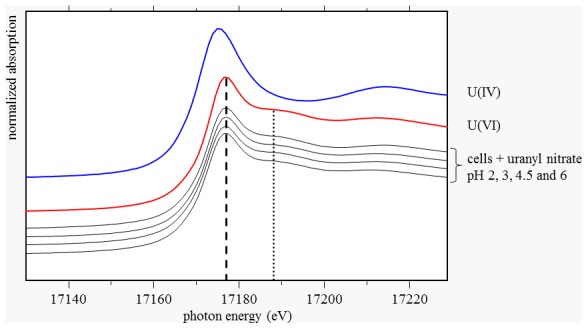
Uranium L
III-edge XANES spectra recorded from the uranium complexes formed by Paenibacillus sp. JG-TB8 at pH 2, 3, 4.5 and 6 under anoxic conditions.In addition, the XANES spectra of two solutions, which serve as reference samples for the uranium oxidation states, one of U(VI) and another one of U(IV), each at a concentration of 4×10−2 M in 1 M HClO4, are shown in the figure. The dashed and the dotted line represent the position of the absorption edge of U(VI) and of the XANES peak resulting from the multiple scattering contribution of the axial oxygen atoms of U(VI), respectively.